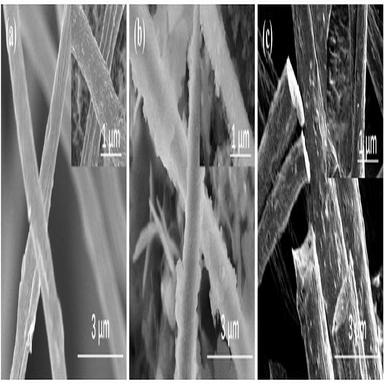
SEM images of CMFs (a), SnSb@CMFs-2 (b) and SnSb@CMF-2@C (c) after 200 cycles.